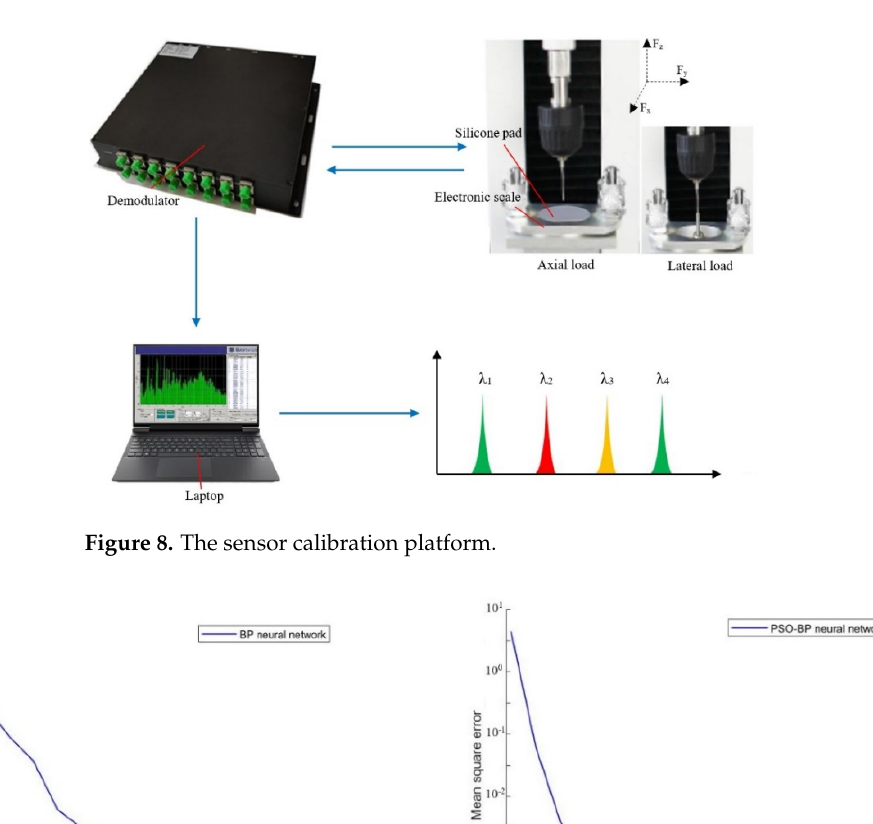
( c ) Figure 11. Output values of each channel when 5N load is applied in Fz direction. ( a ) Fz channel output value; ( b ) Fx channel output value; ( c ) Fy channel output value. The measured and predicted values of the sensor are shown in Figure 12 when we applied different forces to the sensor in the X, Y and Z directions, respectively. Figure 12. The measured and predicted values of the sensor when different forces are applied to the sensor in X, Y and Z directions, respectively.